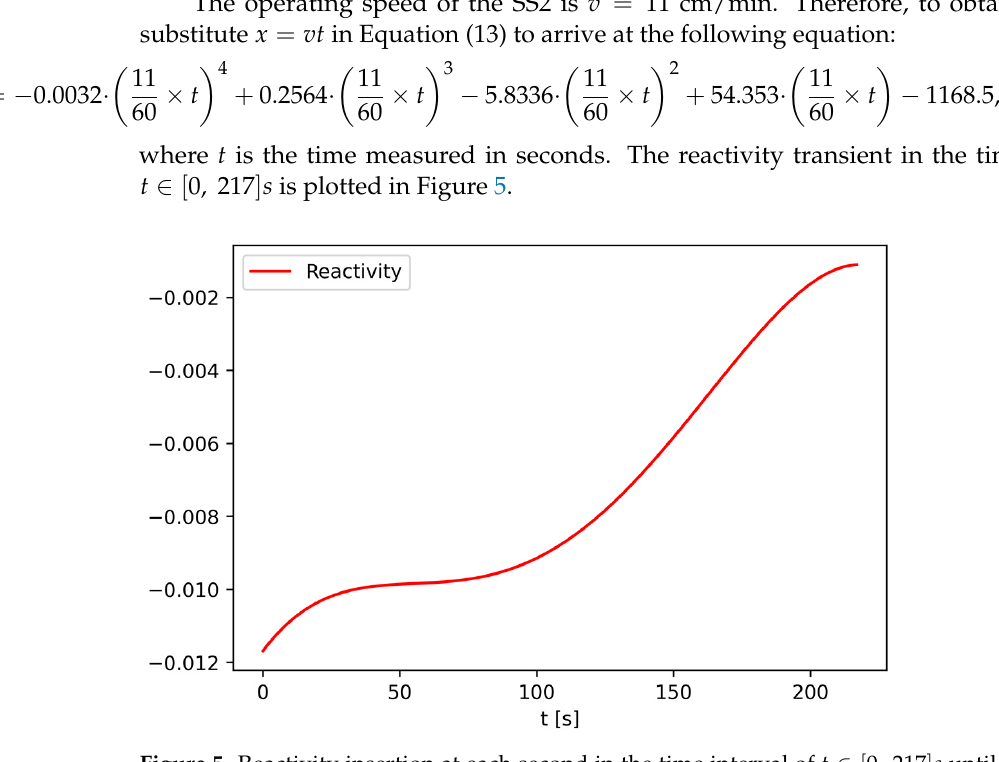
Figure 5. Reactivity insertion at each second in the time interval of t ∈ [ 0, 217 ] s until steady state is reached.